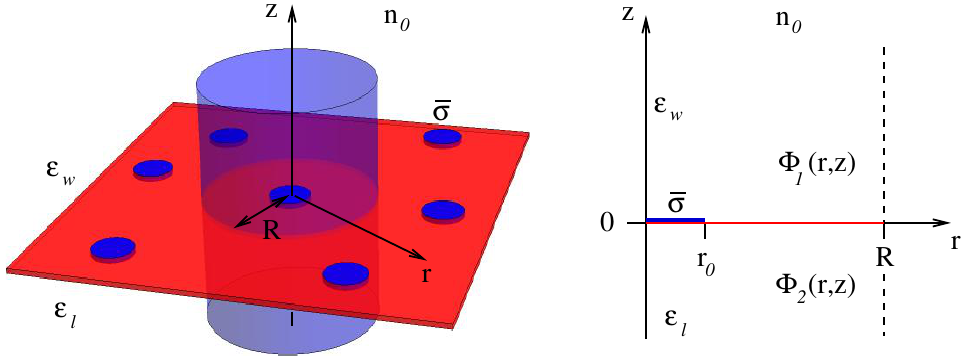
Figure 1. Left side: Charged circular regions (blue disks), each carrying a uniform surface charge density ¯ σ , located at an interface (the red plane) that separates two media with dielectric constants ε w and ε l from each other. The medium with ε w contains a symmetric 1:1 salt solution of bulk concentration n 0 . The blue transparent cylinder of radius R represents a unit cell (the Wigner–Seitz cell). Right side: The unit cell is fully characterized by the r and z directions of cylindrical coordinates with 0 ≤ r ≤ R and − ∞ < z < ∞ . We denote the electrostatic potential for z ≥ 0 by Φ 1 ( r , z ) and for z ≤ 0 by Φ 2 ( r , z )